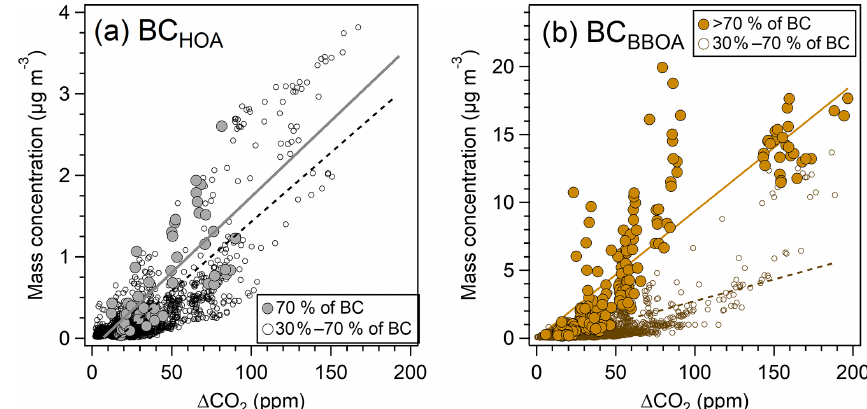
Figure 4. The relationship between BC HOA and BC BBOA to CO 2 concentrations at the residential site. BC HOA (a) and BC BBOA (b) vs. (cid:49) CO 2 concentrations. (cid:49) CO 2 was calculated as CO 2 ( measured ) − CO 2 ( background ) , and CO 2 (background) was 404ppm. The slopes were 0.019 and 0.017 (HOA) and 0.10 and 0.032 (BBOA) for > 70% and 30%–70% of BC, respectively. The values are the 10min average.